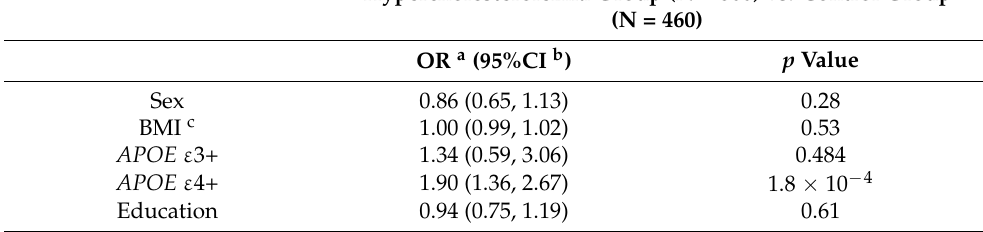
Table 4. Logistic Regression Analysis of Cholesterol-Related